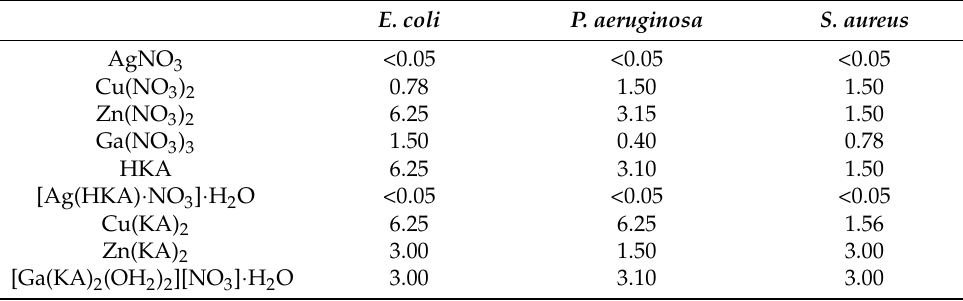
Figure 5. Kirby–Bauer disk-diffusion assay on LB agar plates. Distance zones were normalized to that of AgNO 3 as a value of 1.0. The taller the bar, the more antimicrobial the compound is. Standard errors are presented from 3–5 trials.